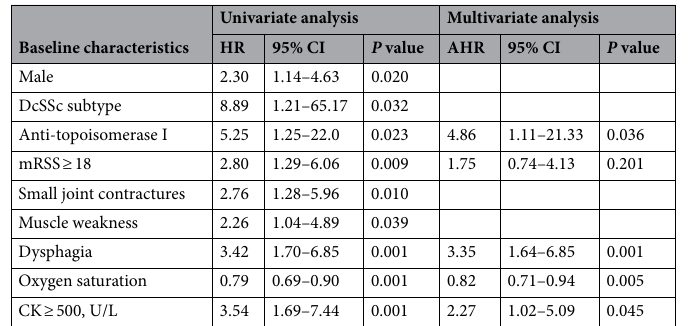
Table 3. Predictors of SSc-CM determined by echocardiography. AHR Adjusted hazard